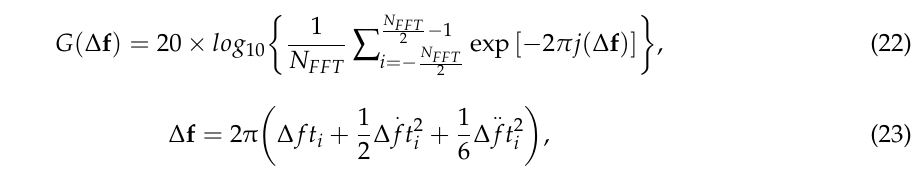
Figure 7. Coherent loss due to residual Doppler rate for different coherent integration time: ( a ) 0.01 s ( ∆𝐹 = 100 Hz ); ( b ) 0.1 s ( ∆𝐹 = 10 Hz ).